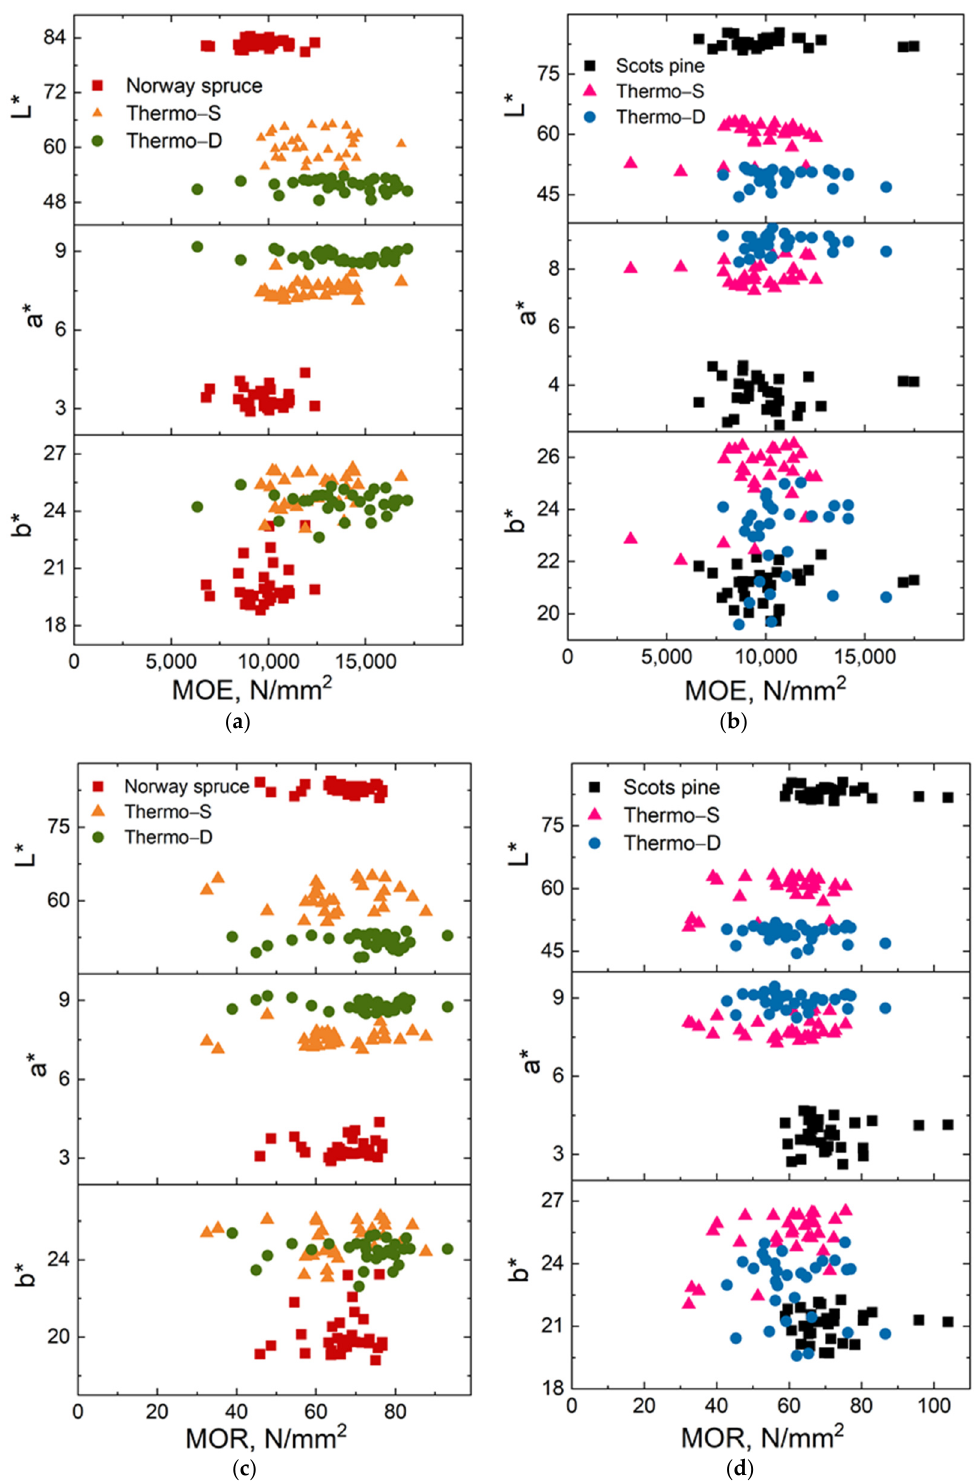
Figure 8. MOR plotted as a function of PC1 and PC2 scores for untreated and Thermo-Wood ® Nor- way spruce and Scots pine. Better cluster separation was found between L*, a*, and MOE/MOR for both wood species between untreated and thermal modified timber, but no real cluster separation could be identified between the b* parameter and MOE/MOR values (Figure 9).